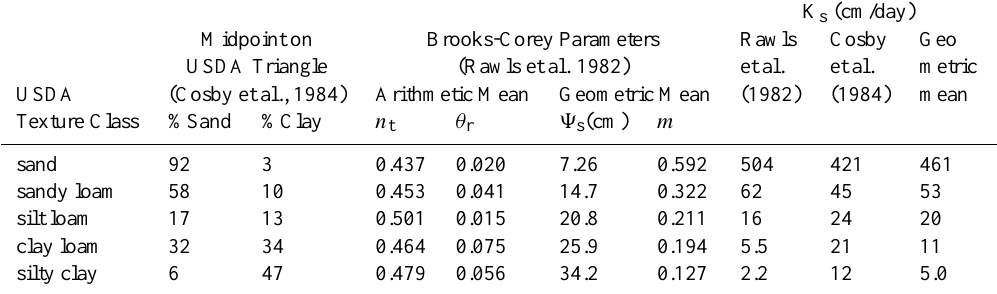
Table 2. Values of soil hydraulic parameters.